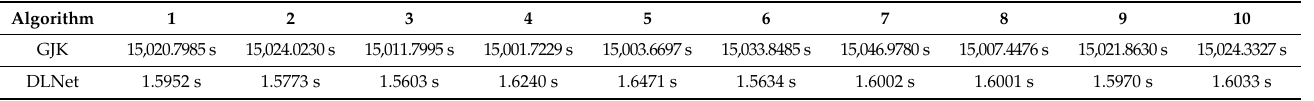
Table 3. Dataset collision detection time of DLNet and GJK (ten detection times).